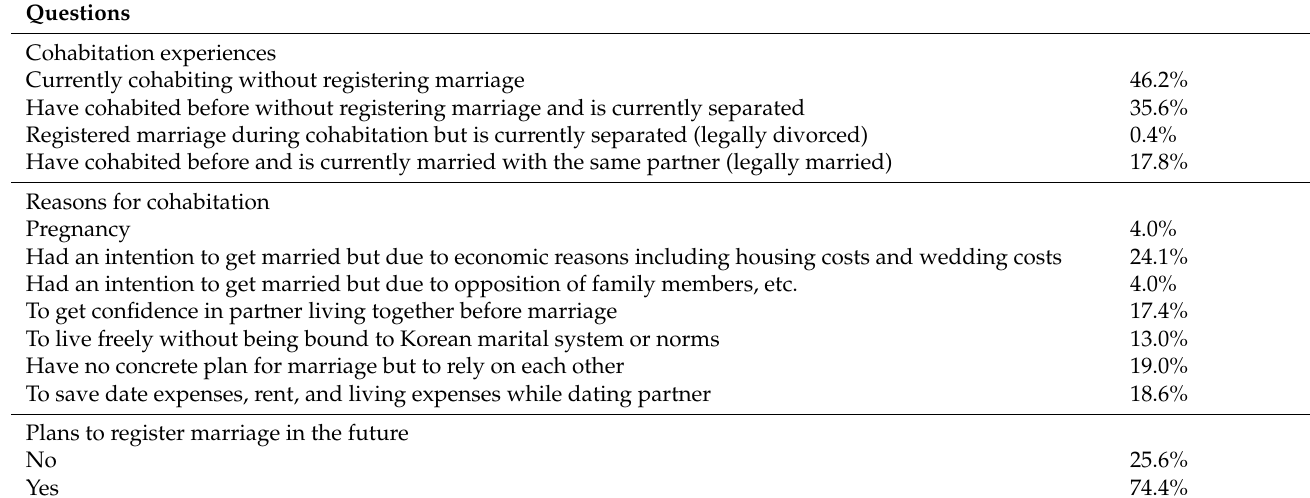
Table 3. Cohabitation experiences of online survey respondents ( n = 253)